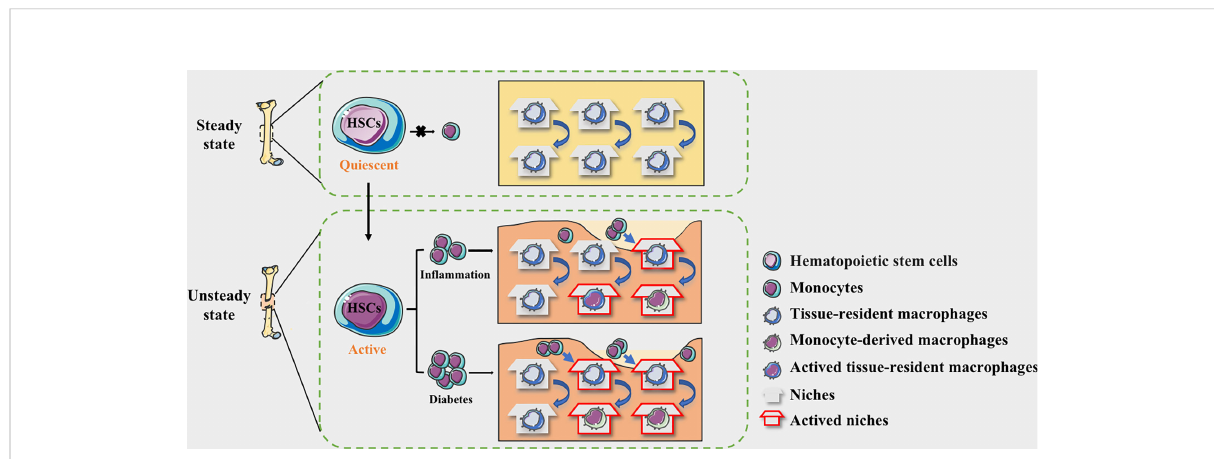
FIGURE 1 The niche of macrophages in bone tissues. HSC-derived macrophages form the tissue-resident macrophages and remain quiescent. The macrophages in the physiological bone niche are mostly inactive TRMs, maintaining homeostasis through moderate self-proliferation. HSCs could be activated by the stimulation of in fl ammation and the myeloid differentiation will enhance, allowing monocytes to circulate into bone tissue. The niche of resident macrophages can also be selectively activated according to the degree of in fl ammation, while monocyte-derived pro-in fl ammatory macrophages occupy available niches to maintain homeostasis. In diabetes, more available niche are occupied by pro- in fl ammatory macrophages, making the bone regeneration micro environment maintaining in a long-term pro-in fl ammatory